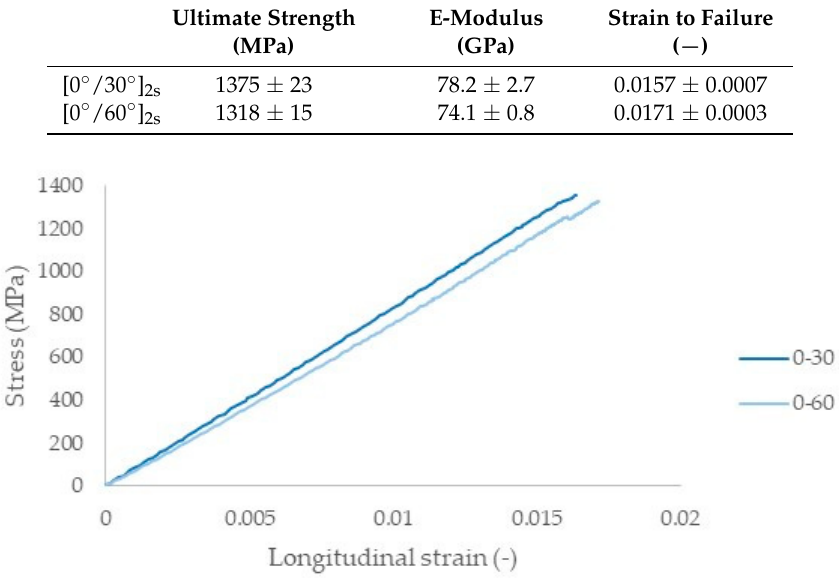
Figure 3. Stress-longitudinal strain curves of the angle-ply laminates.